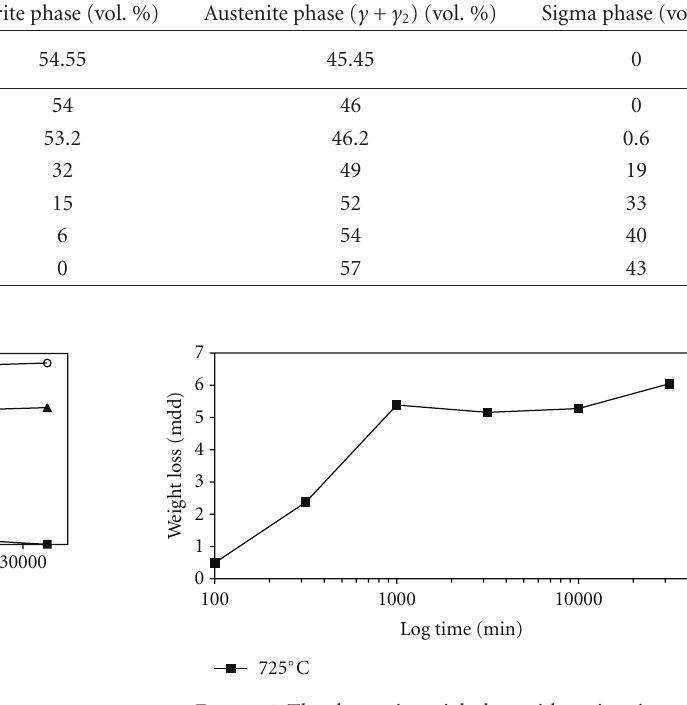
Figure 4: The change in weight loss with ageing time.